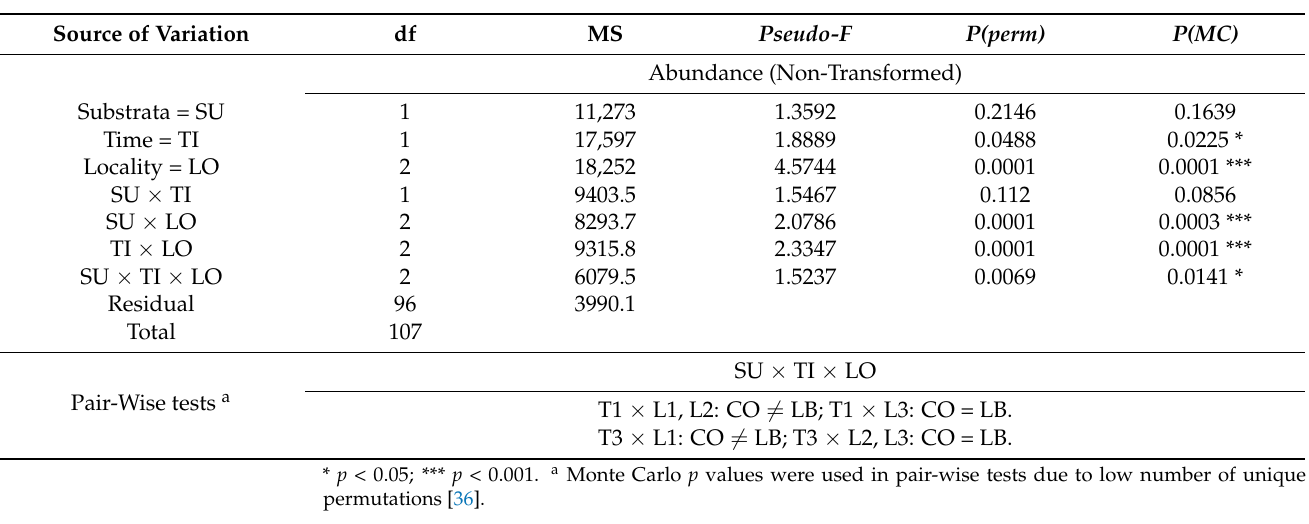
Table 3. Results of PERMANOVA examining the abundance of caprellid community assemblages found in each substrata type (SU, CO = experimental collectors and LB = local basibionts), time of deployment (TI, T1 = one month, and T3 = three months) and each locality (LO, L1 = Sancti Petri, L2 = Rota and L3 = Puerto Am é rica). MS = mean square; df = degrees of freedom; P(MC) = Monte Carlo p values.